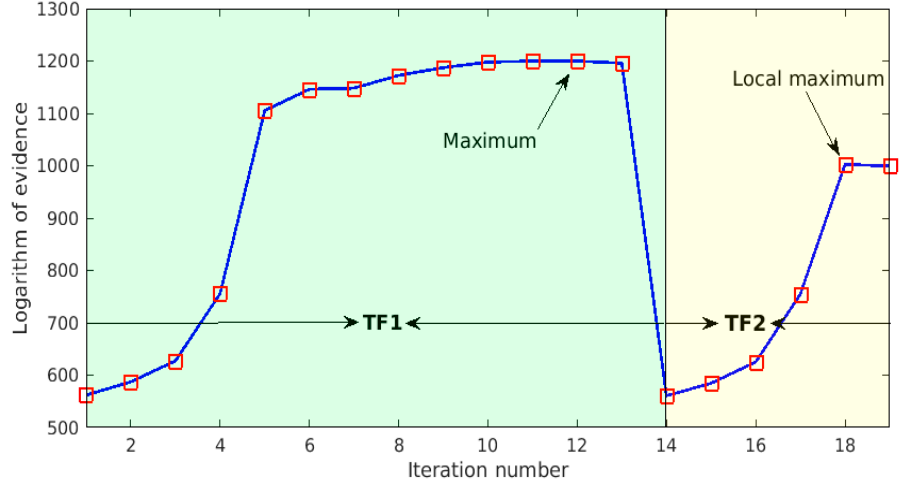
Figure 5. Iteration history of the model class selection procedure.